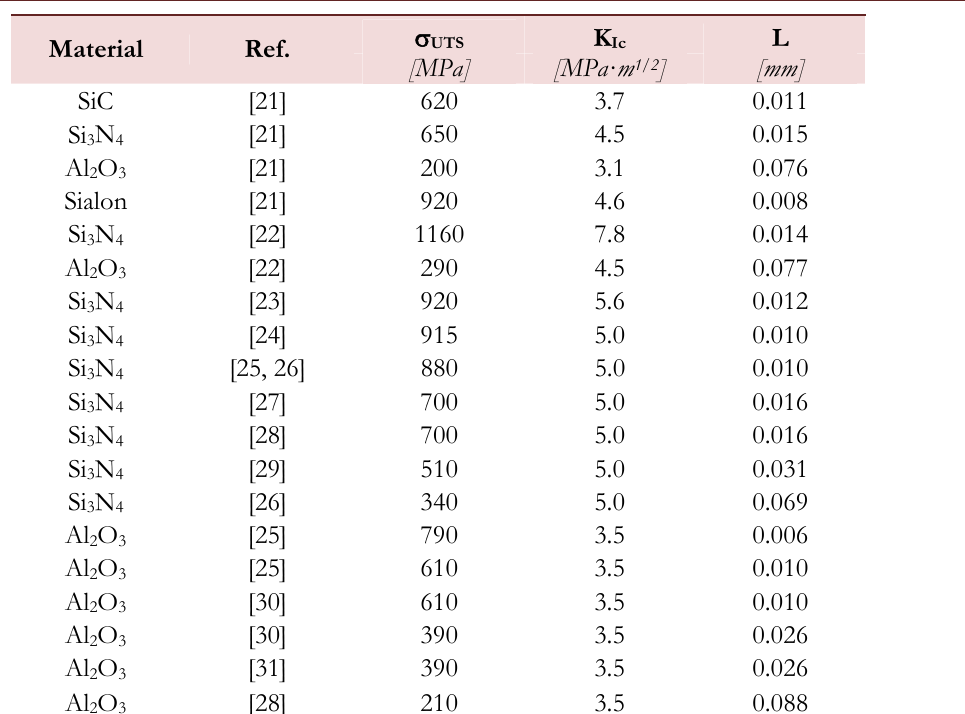
Table 1: Mechanical properties of the investigated engineering ceramics.